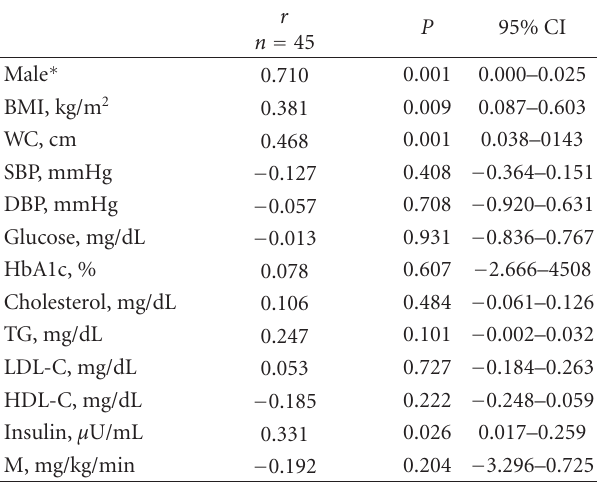
Table 2: Bivariate correlation between uric acid and variables of the study.